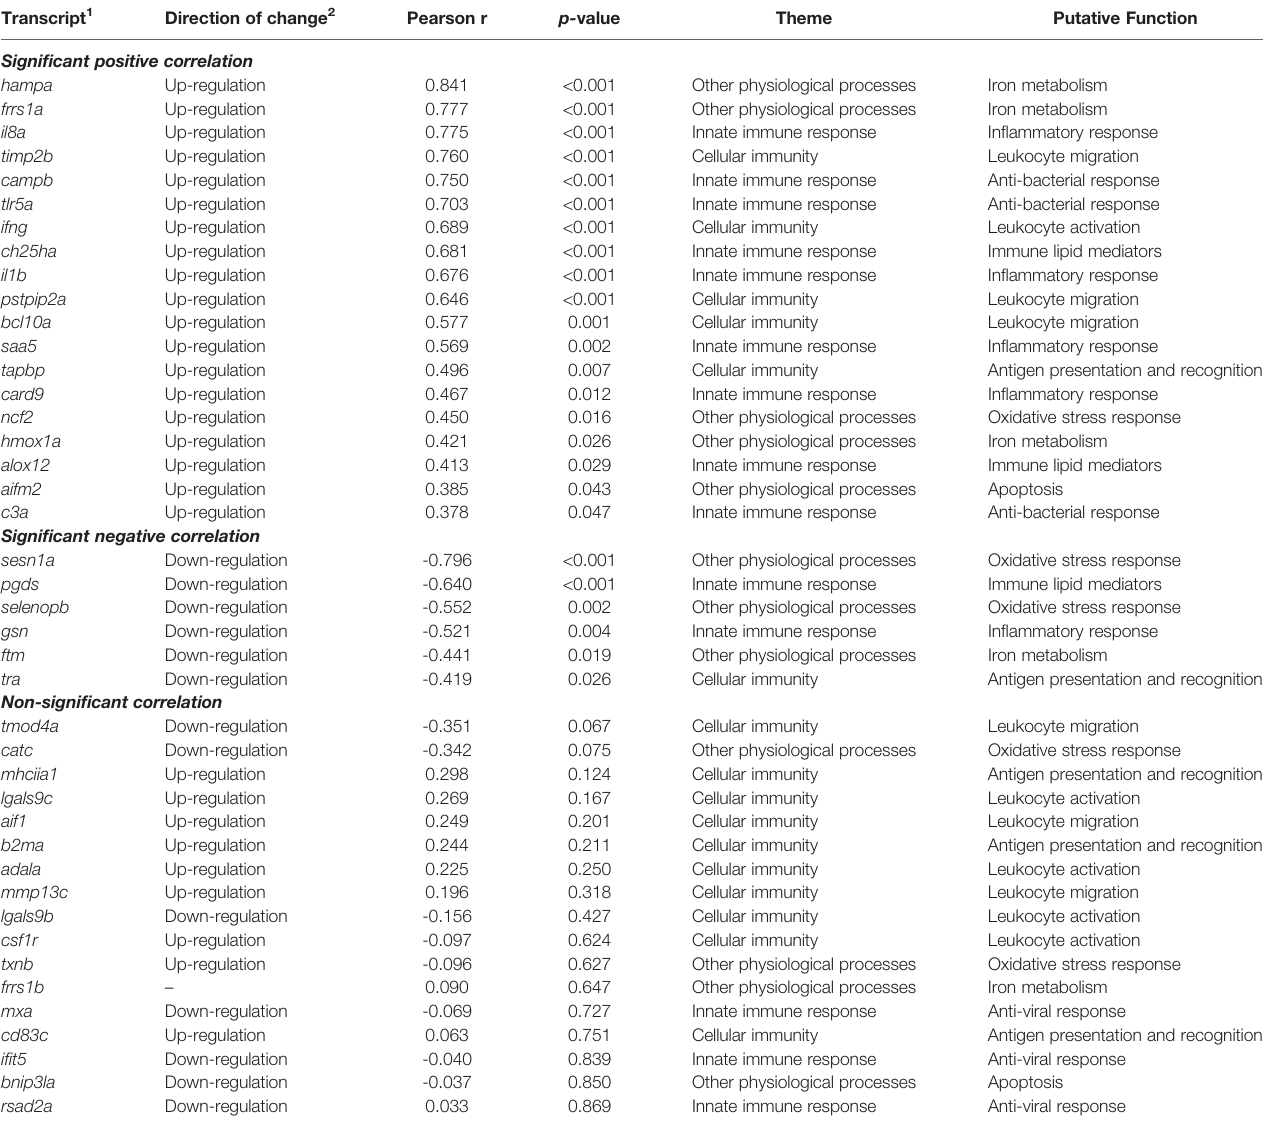
TABLE 1 | Correlation analyses for the expression of qPCR-studied transcripts with the level of P. salmonis